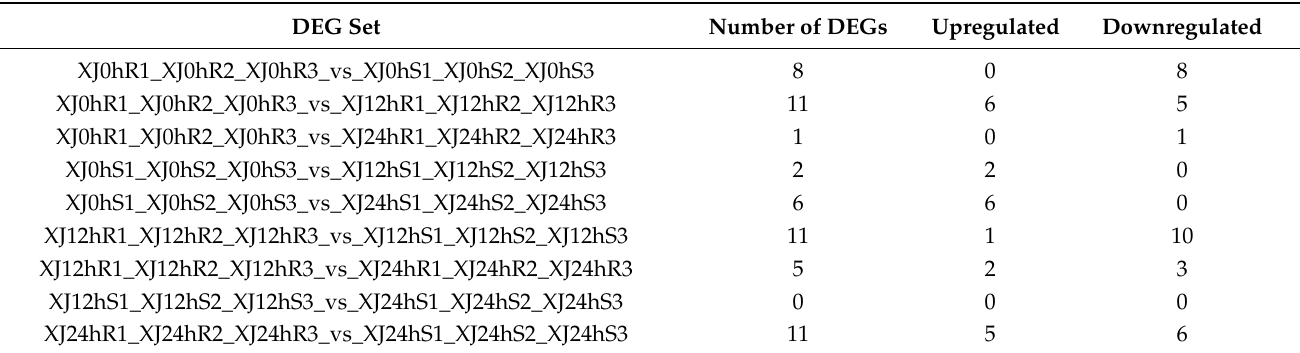
Table 4. The number of differentially expressed circRNAs and their statistics.